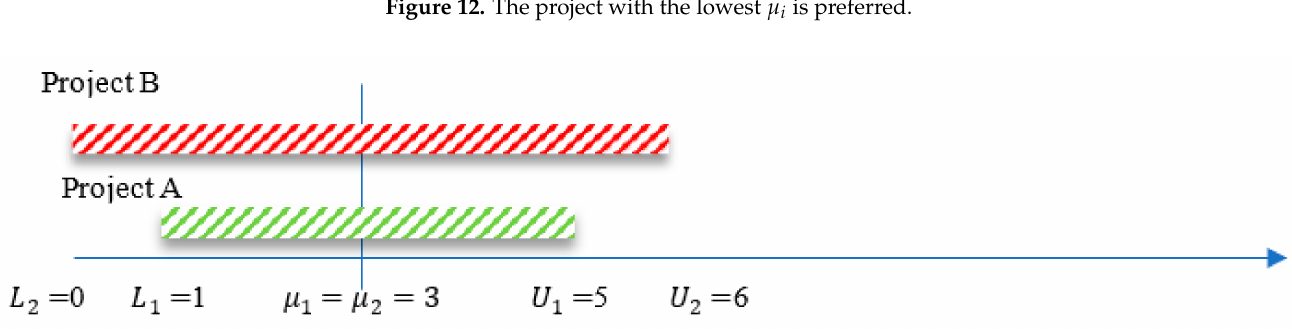
Figure 12. The project with the lowest µ i is preferred.